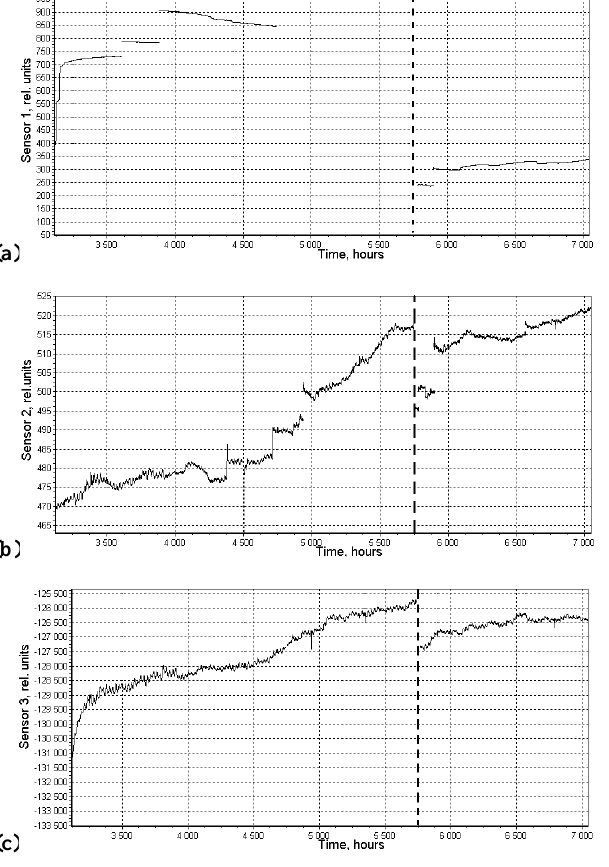
Fig. 1. Data of sensors 1, 2, 3 ( a , b , c , respectively). Hour samplings are shown. Earthquake beginning is marked by dotted